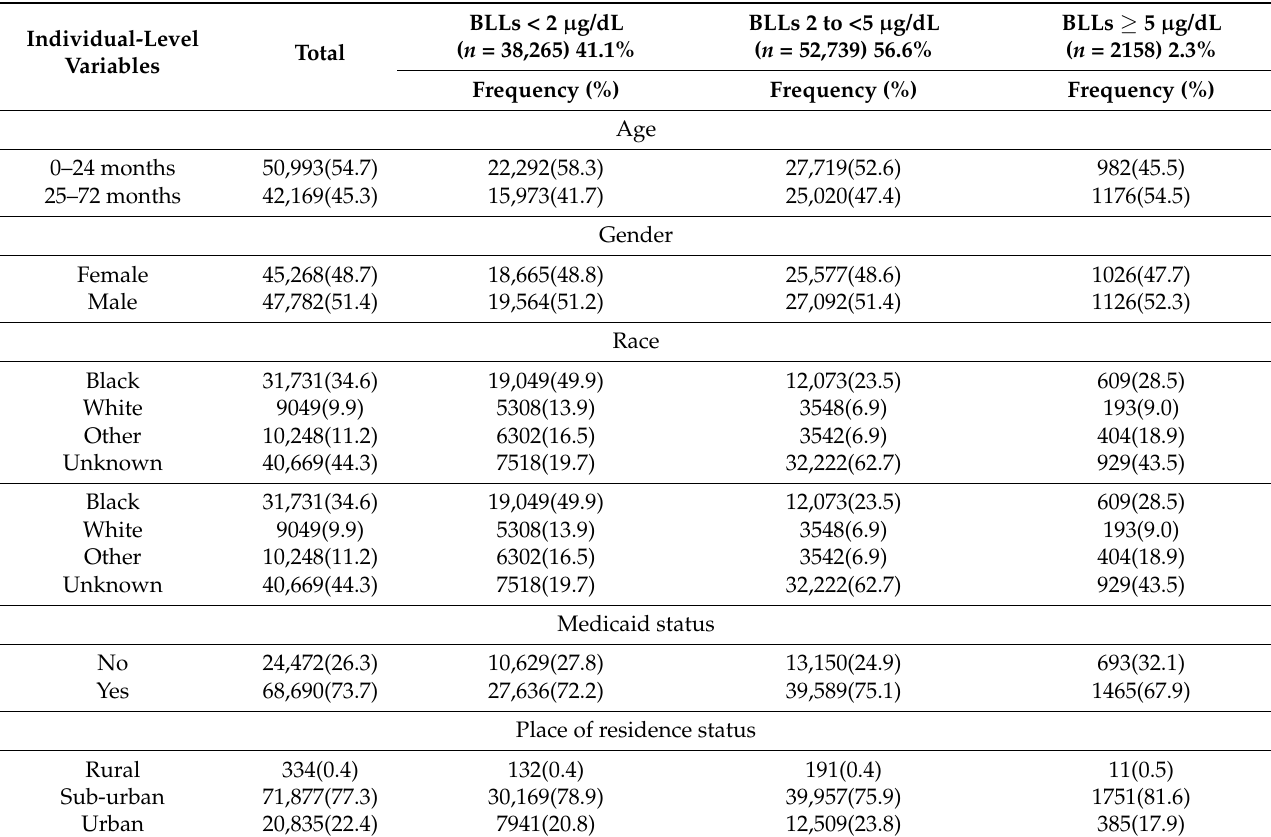
Table 1. Individual-level demographic characteristics of 93,162 children aged 0–72 months living in 20 counties in or near the Atlanta Metropolitan Statistics area who had a valid venous blood lead test in the years 2010–2018, by BLL category.